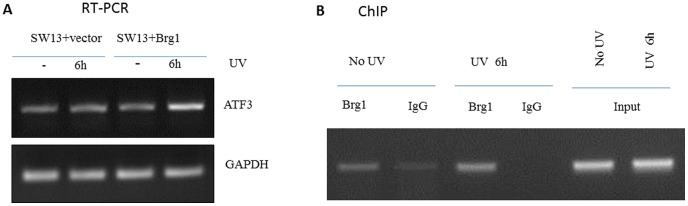
BRG1 controls ATF3 expression under UV conditions.(A) RT-PCR analysis of ATF3 gene expression in SW13+vector and SW13+BRG1 cells. Both cells were collected 6 hours after UV treatment. RNA was purified and RT-PCR products were analyzed on agarose gel. (B) Binding of BRG1 to ATF3 gene promoter region. 293T cells were UV irradiated and incubated for 6 hours followed by Chromatin Immunoprecipitation (ChIP) assay with anti-BRG1 antibody.